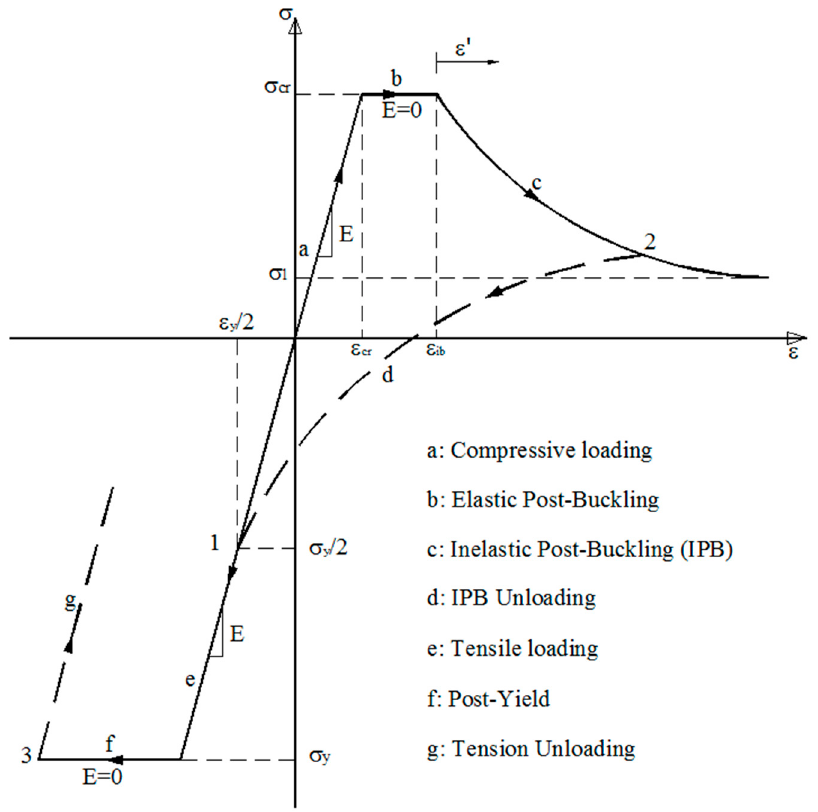
Figure 1. Stress–strain constitutive model of the nonlinear truss [38].